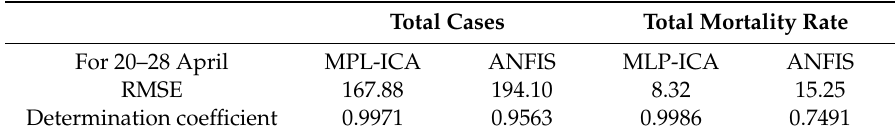
Table 7. Validation of the models for 9